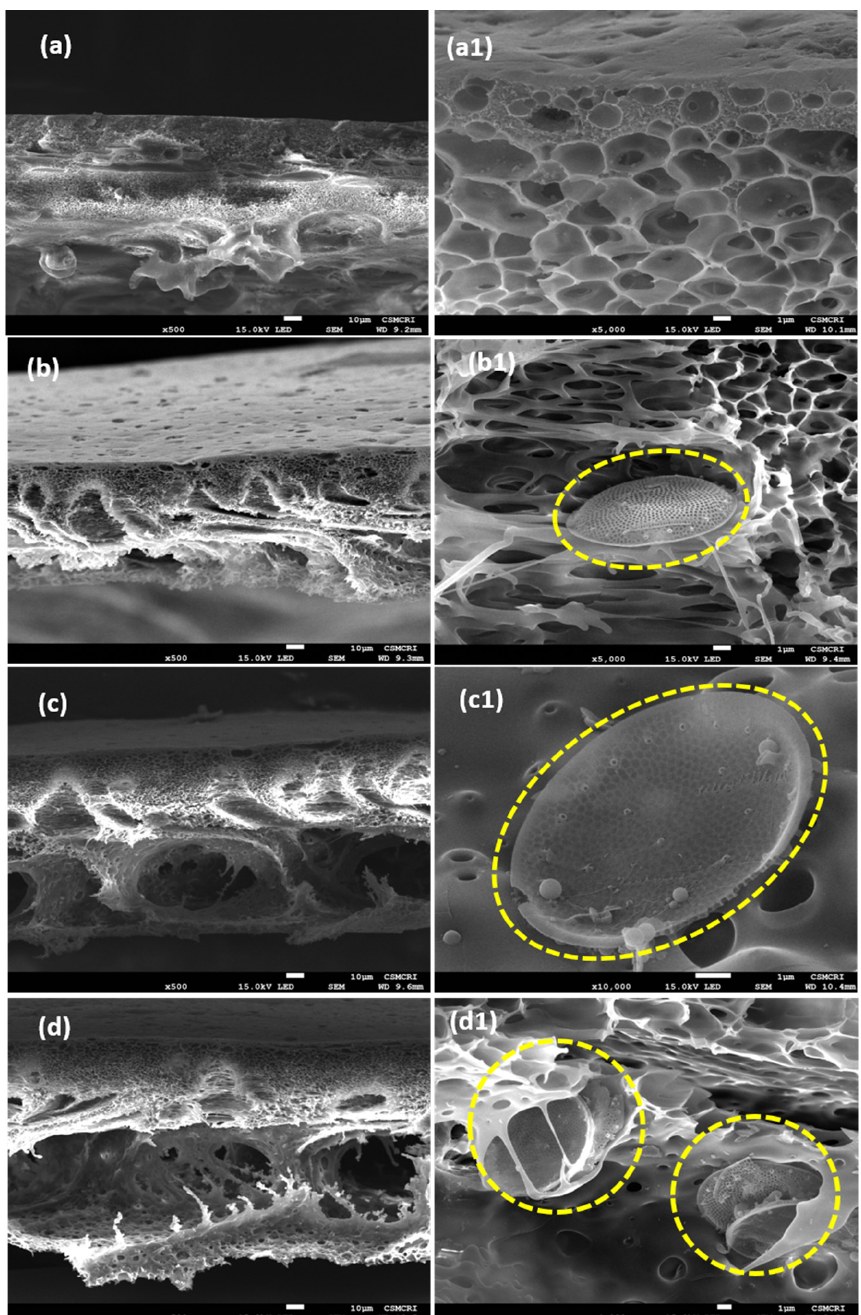
Figure 8. Cross-sectional morphology of diatomite hybrid membrane. SEM images on the left side represent the control, ( a ) PSF/PVP/Dia 0 . 0 , and diatomite hybrid membranes, ( b ) PSF/Dia 0 . 1 , ( c ) PSF/Dia 0 . 2 , and ( d ) PSF/Dia 0 . 5 , at ×500 magnification. Images on the right side ( a1 – d1 ) were scanned at higher magnification (×5000), denoting the presence of diatom silica frustules in membrane cross sections of ( b – d ), except in the control ( a1